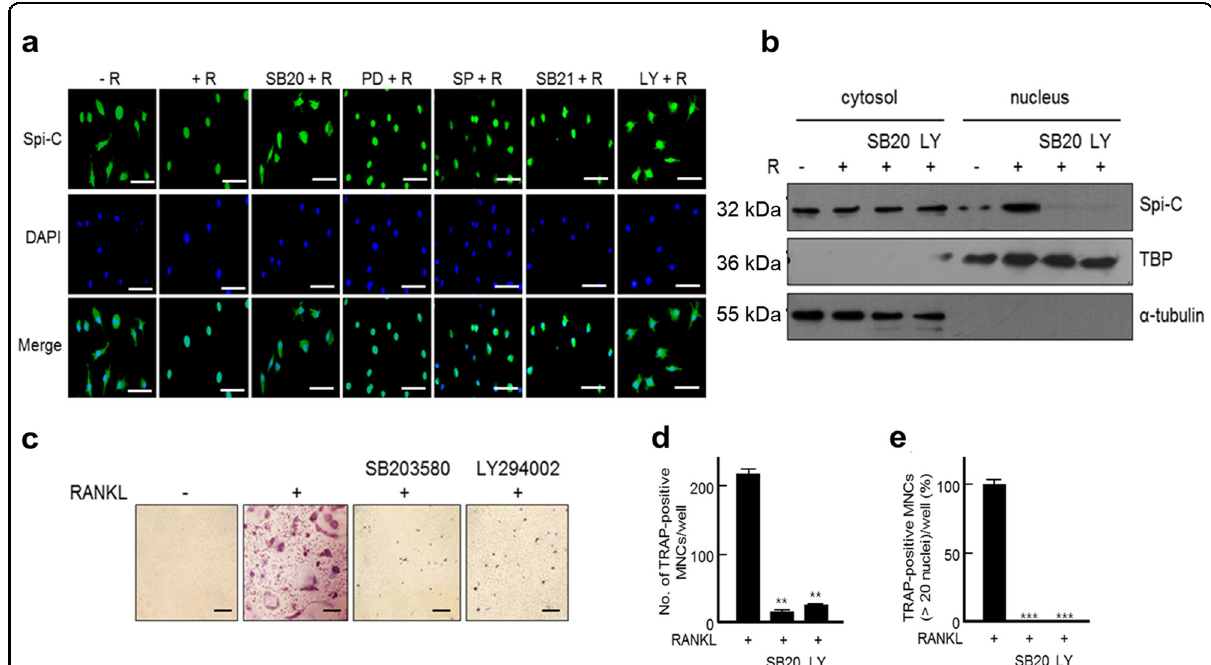
Fig. 5 Nuclear translocation of Spi-C through p38 and PI3K. a BMMs that had been serum starved for 6 h were pretreated with the inhibitors SB203580 (SB20, 20 μ M), PD98059 (PD, 20 μ M), SP600125 (SP, 10 μ M), SB216763 (SB21, 100 nM), and LY294002 (LY, 5 μ M) for 30 min and then incubated with RANKL (200 ng/ml) for 90 min. Then, the cells were subjected to immuno fl uorescence staining for Spi-C. The nuclei were stained blue with DAPI. The cells were observed and imaged under a fl uorescence microscope. Scale bars, 100 μ m (original magni fi cation, ×400). b RAW264.7 cells were treated with RANKL (200 ng/ml) for 2 days to induce Spi-C expression and serum starved for 6 h. The cells were pretreated with SB203580 (SB20, 20 μ M ) or LY294002(LY, 5 μ M) for 30 min and then incubated with RANKL (50 ng/ml) for 60 min. Then, the cells were subjected to nuclear fractionation. Tubulin and TBP were used as markers for the cytosol and nucleus, respectively. c – e The isolated BMMs were pretreated with SB203580 (SB20, 20 μ M) or LY294002 (LY, 5 μ M) for 30 min and then incubated with RANKL (200 ng/ml) for 5 days. Thereafter, TRAP staining was performed (original magni fi cation, ×100) ( c ), and the number of TRAP + MNCs (>3 nuclei) d or large TRAP + multinucleated osteoclasts with >20 nuclei e were counted and are presented as relative percentages (%). Scale bars, 100 μ M c . The data are presented as the mean ± SD of three independent experiments. ** p < 0.005, *** p < 0.001 vs. RANKL-treated